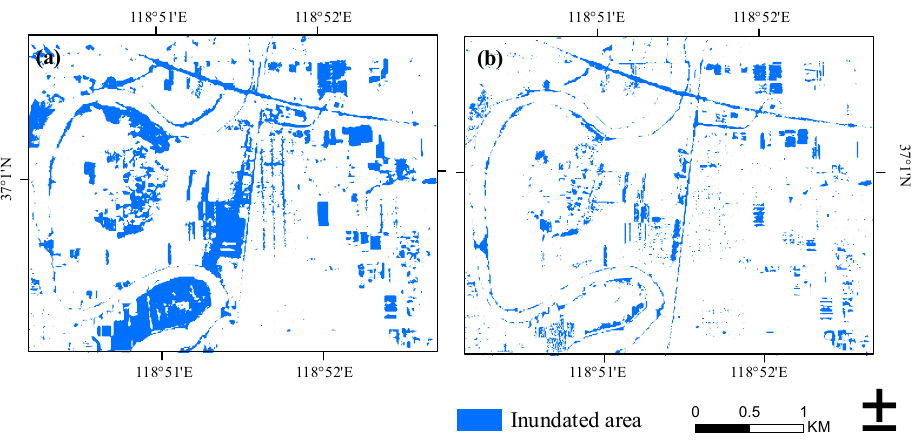
Figure 10. Flood map produced by normalized di ff erence water index (NDWI) on 21 August 2018 ( a ) and 27 August 2018 ( b ).